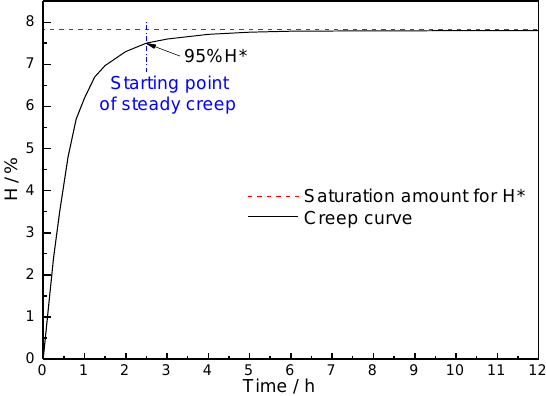
Figure 8. Typical creep curve showing the variety of H with time.